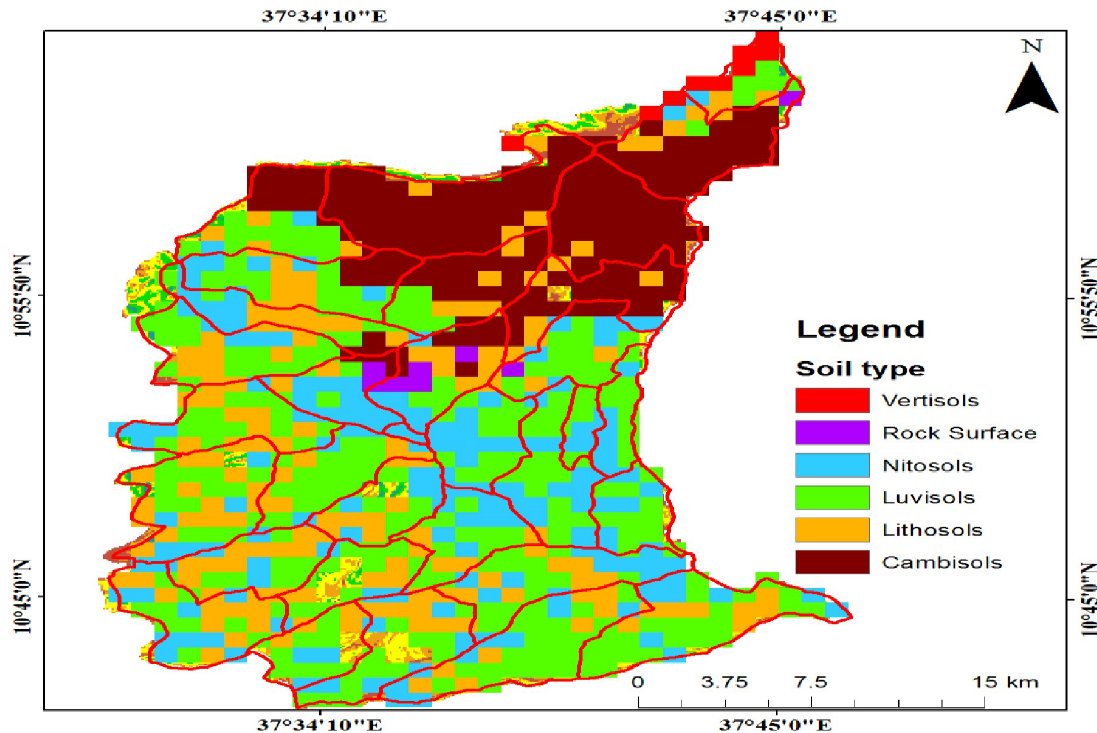
Fig 2. Soil map of Dega Damot district (data source: MoWIE), our study does not need to supply a copy right notice for Fig 2. Because the shape file data for soil map obtained from the Geographic Information System (GIS) department of the Ministry of Water, Irrigation and Electricity (MoWIE), is free and open to